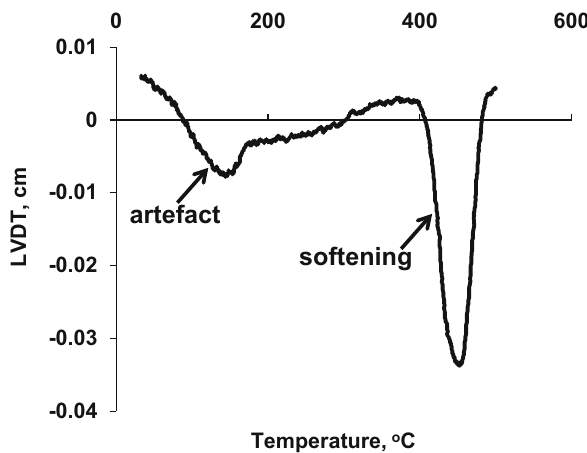
Fig. 5 Baseline-subtracted dilatometry plots for a Pocahontas No. 3 coal in high-pressure CO 2 (without higher-precision